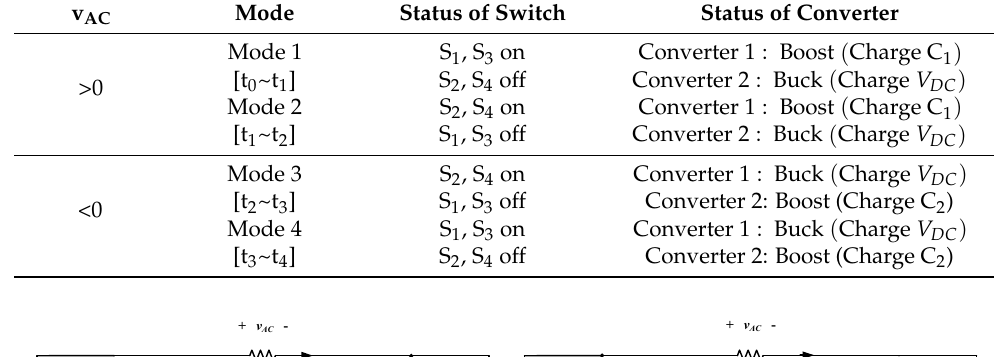
Table 1. The operation modes of Converter 1 and Converter 2.